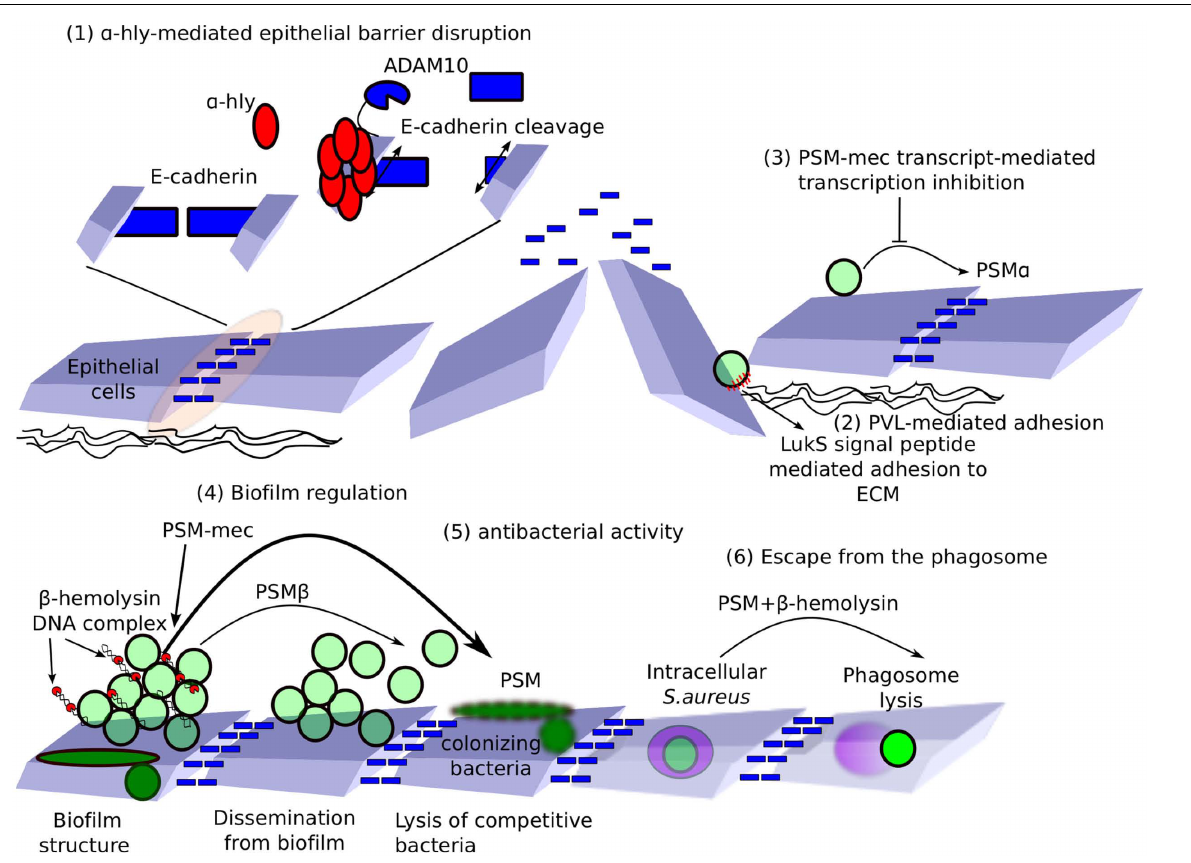
FIGURE 2 | Non-lytic functions of hemolysins, bi-component toxins, and PSMs. (1) E-cadherin is important for maintaining tight junctions and epithelial barrier function. α -Hemolysin binds ADAM10 and relocalizes it to E-cadherin-containing microdomains. ADAM10 cleaves E-cadherin, leading to loss in epithelial barrier function. (2) Exposure of the underlying glycosaminoglycans-rich extracellular matrix to LukS-PV signal peptide favors S. aureus adhesion. (3) PSM-mec RNA controls the transcription of virulence